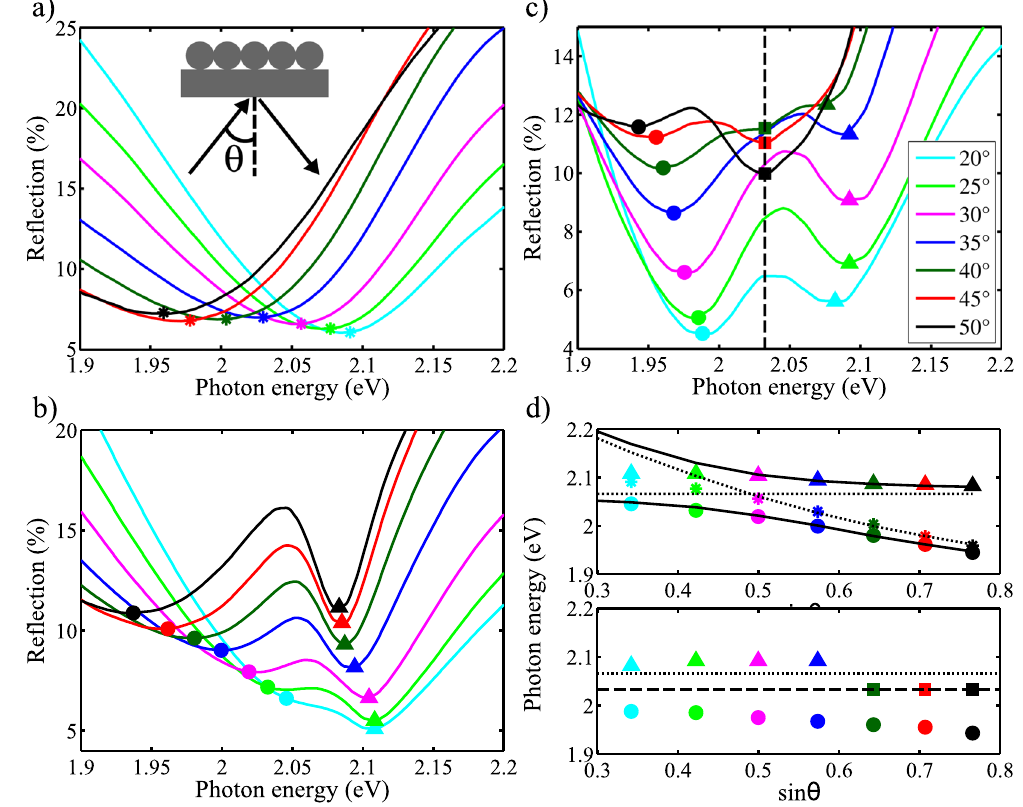
Figure 2. Experimental reflection spectra of a plasmonic opal as a function of incidence angle for the following structures: (panel (a)) a bare opal array without molecules, (panel (b)) covered by TDBC molecules at low concentration in the PDAC film, and (panel (c)) covered by TDBC molecules at high concentration in the PDAC film. The top of panel (d) shows dispersion relations of the experimentally observed (i) lower (shown as circles) and (ii) upper (shown as triangles) polaritonic branches extracted from spectra in case of a low concentration of TDBC molecules together with (iii) the bare Bragg plasmon mode (shown as stars). Their corresponding calculated branches are also represented as solid and dashed line, respectively. The non dispersive dashed line corresponds to the transition energy of the TDBC J-aggregates. The bottom of panel (d) shows dispersion relations of the experimentally obtained (i) lower (shown as circles) and (ii) upper (shown as triangles) polaritonic branches obtained in case of a high concentration of TDBC molecules together with (iii) the third mode (squares). The short and long dashed lines correspond to the transition energy of the TDBC J-aggregates and the calculated dispersion-less relation of the third